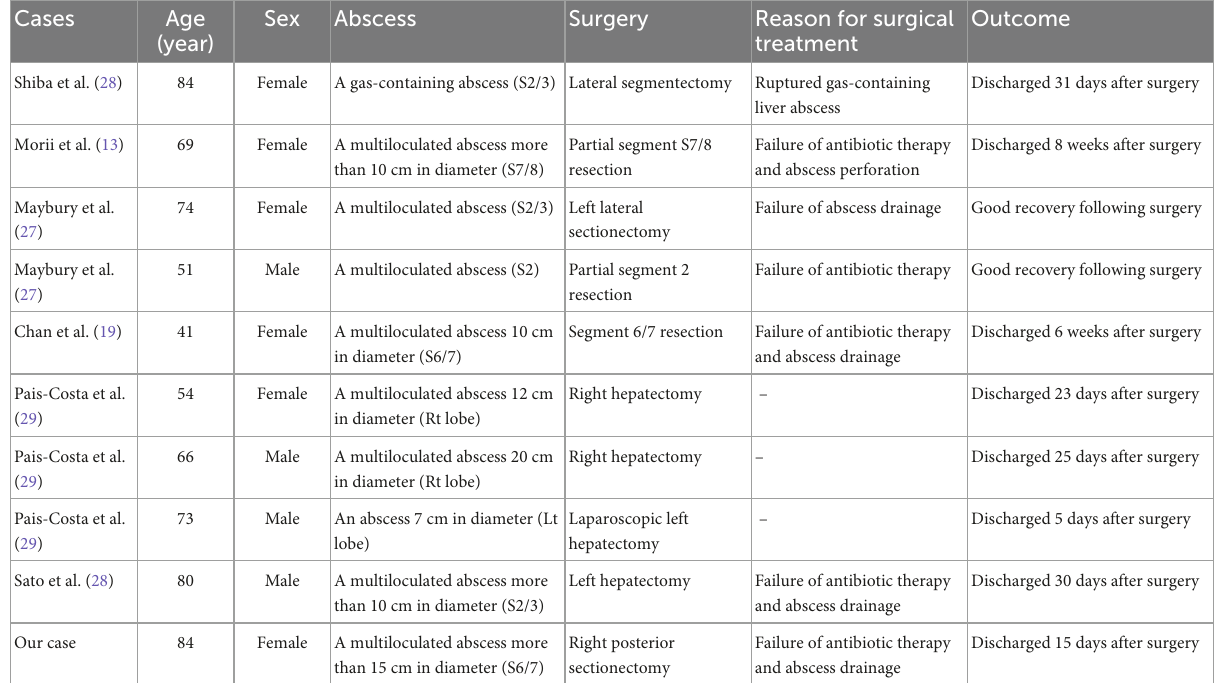
TABLE 1 Reported cases of hepatectomy for Klebsiella pneumoniae